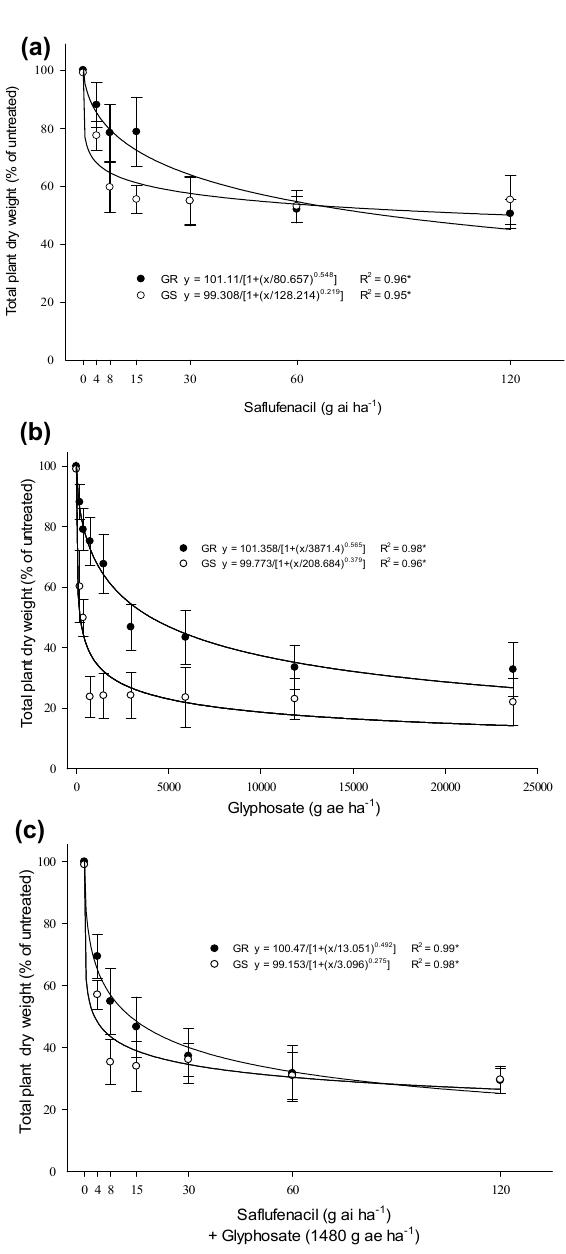
Figure 1. Plant total dry weight reduction of glyphosate-resistant (GR) and -sensitive (GS) Conyza bonariensis biotypes at 28 days after transplant (DAT) with (a) saflufenacil (0, 3.75, 7.5, 15, 30, 60, and 120 g ha − 1) , (b) glyphosate (0, 185, 370, 740, 1480, 2960, 5920, 11,840, and 23,680 g ae ha − 1 ), and (c) glyphosate (1480 g ae ha − 1 ) combined with saflufenacil rates of 0, 3.75, 7.5, 15, 30, 60, and 120 g ha − 1 . Lines are the response curves predicted from non-linear regression; symbols represent mean dry weight (% reduction compared with untreated) of three replicates, and vertical bars show the 95% confidence intervals (CI).